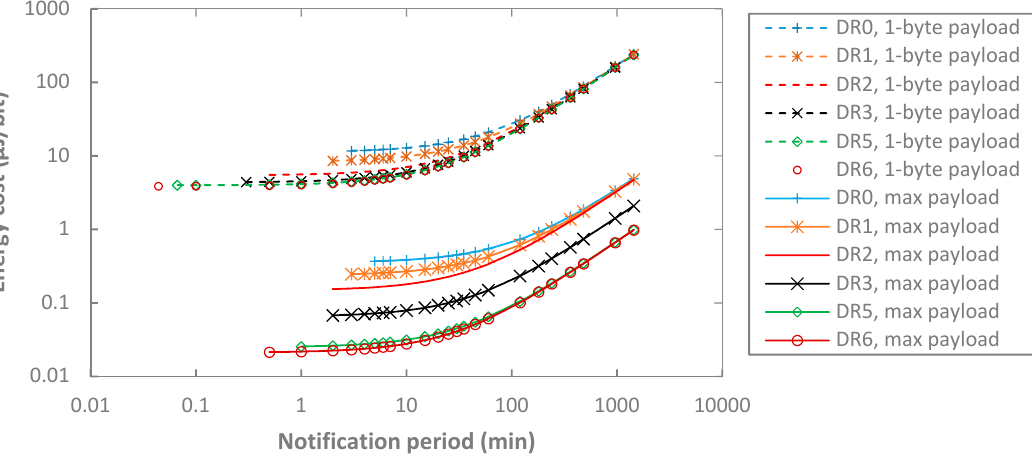
Figure 19. Energy cost of data delivery as a function of T Notif , for different DR settings, BER = 0, p coll = 0, and for 1-byte payload and maximum-sized payload that corresponds to each DR.